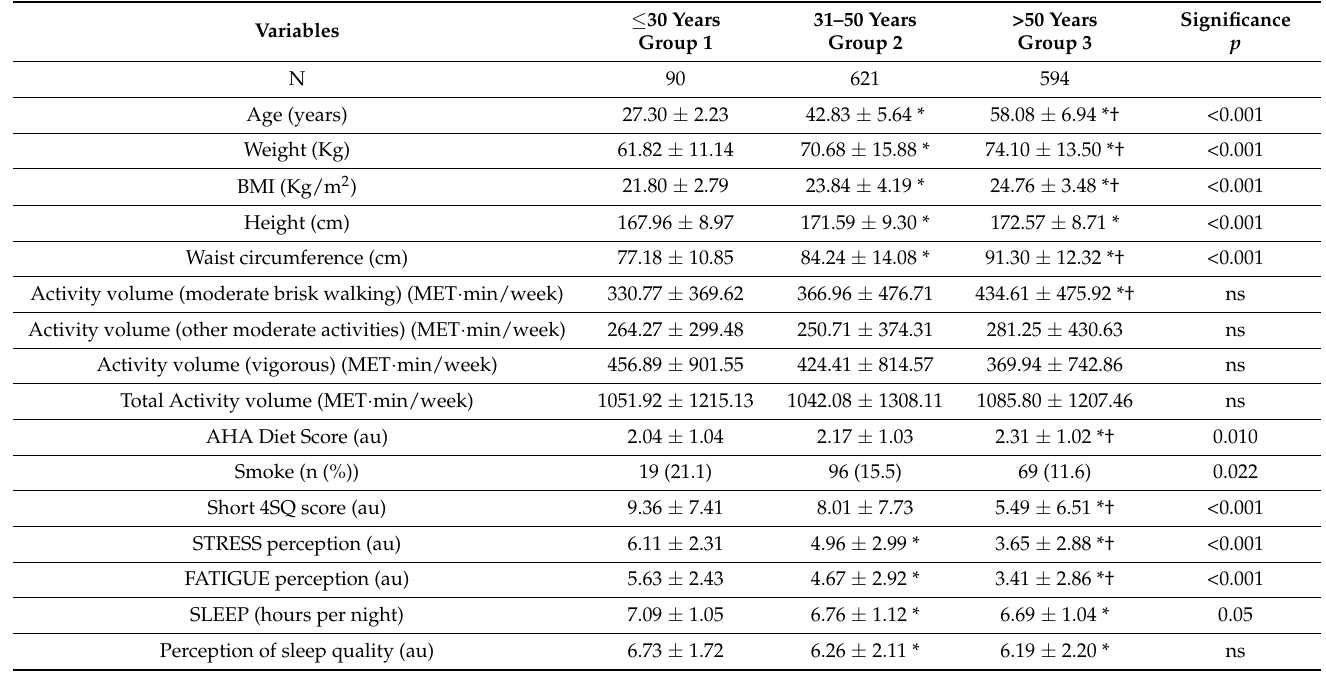
Table 1. Anthropometric and lifestyle data collected in the three age